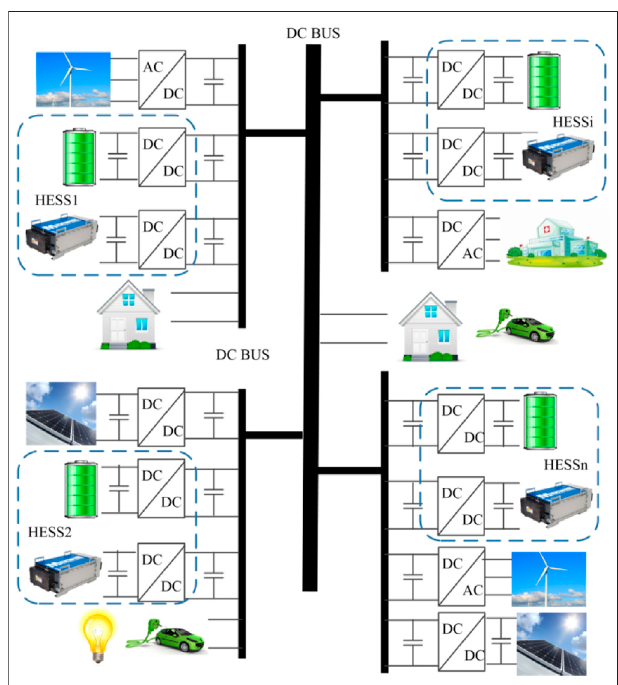
FIGURE 1 | Schematic diagram of DC microgrid with